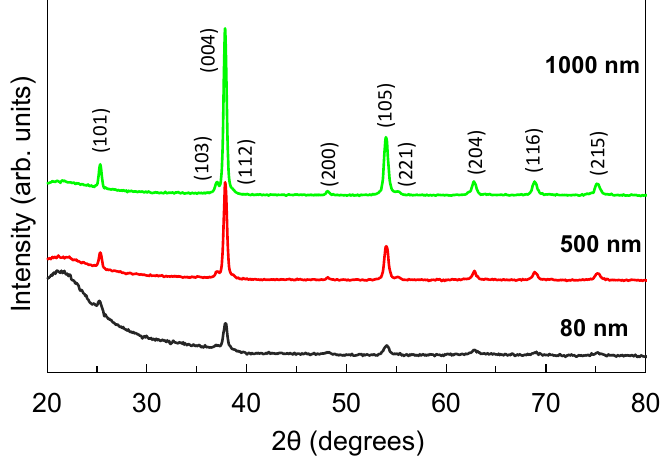
Figure 12. GIXRD spectra for the TiO 2 films deposited on SiO 2 substrate with thicknesses of 80 nm,